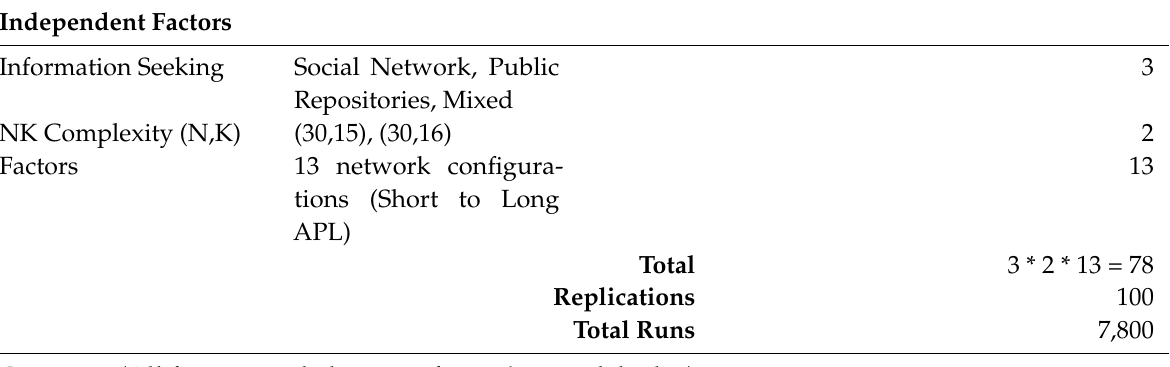
Table 2: Summary of the knowledge transformation model. Independent